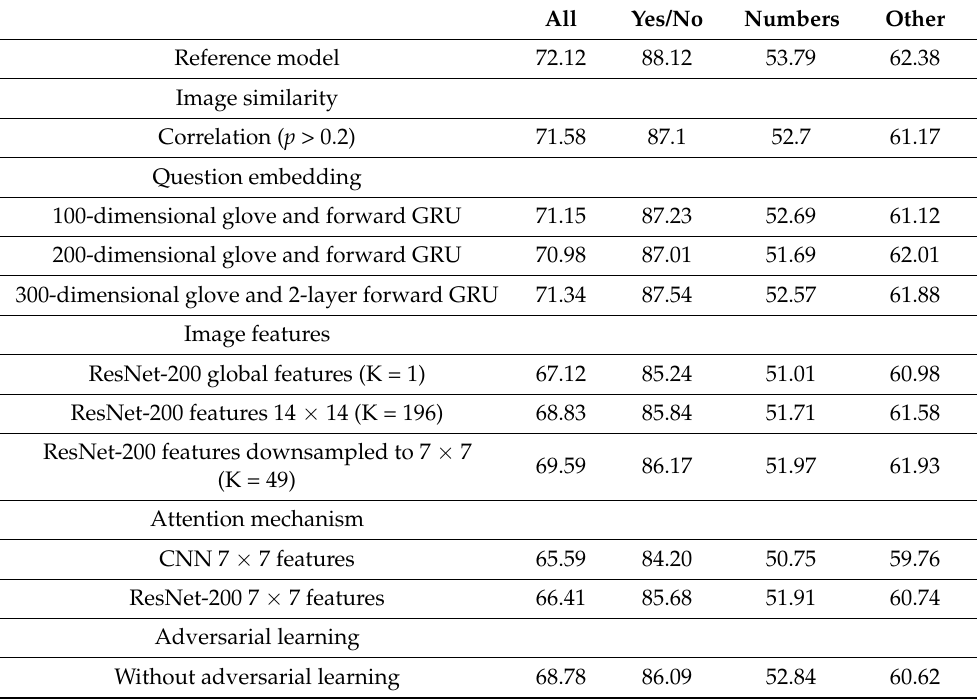
Table 1. VQA 2.0 validation